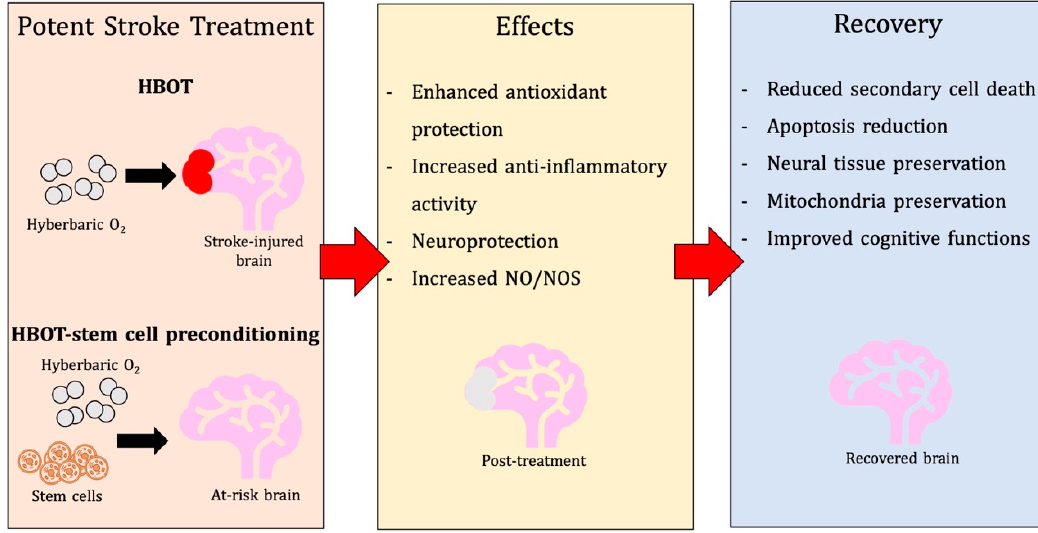
Figure 1. Hyperbaric oxygen therapy (HBOT) effects on Antioxidants and NO.